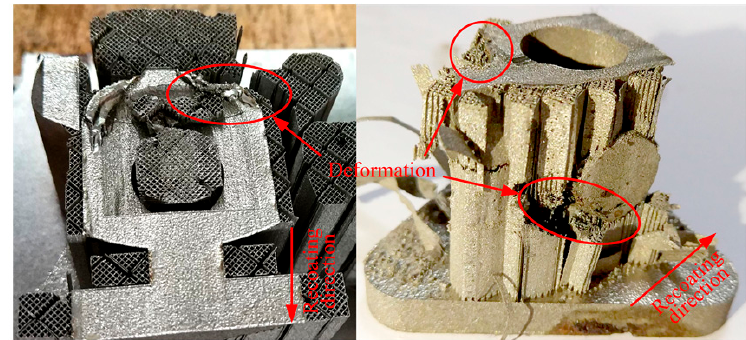
Figure 2. A failed part due to the improper geometric design of support structures.